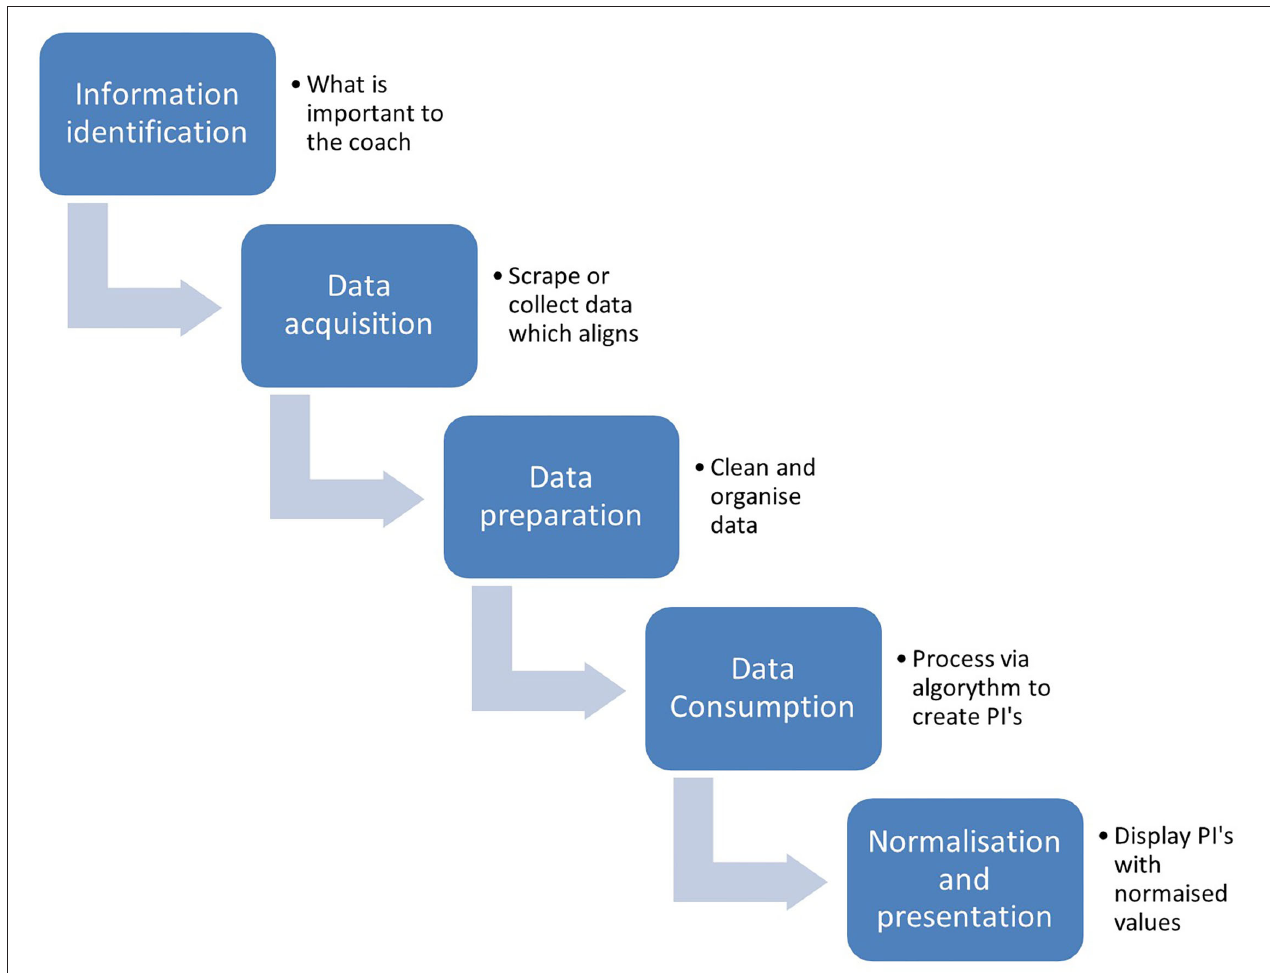
FIGURE 1 | Pipeline for automated data management for display in visualisation